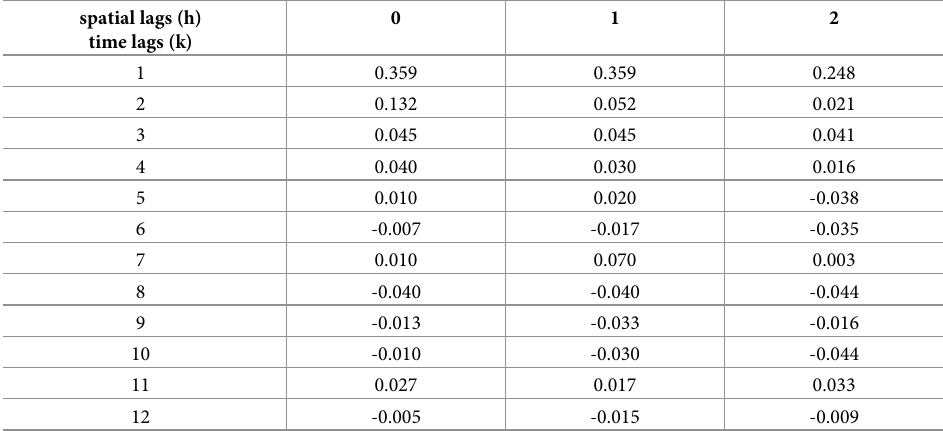
Table 8. PACF values of HFRS incidence after seasonal difference adjustment.